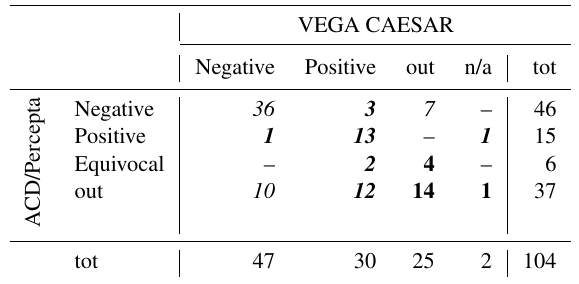
Table 2. Results of the QSAR genotoxicity predictions from VEGA CAESAR and ACD/Percepta